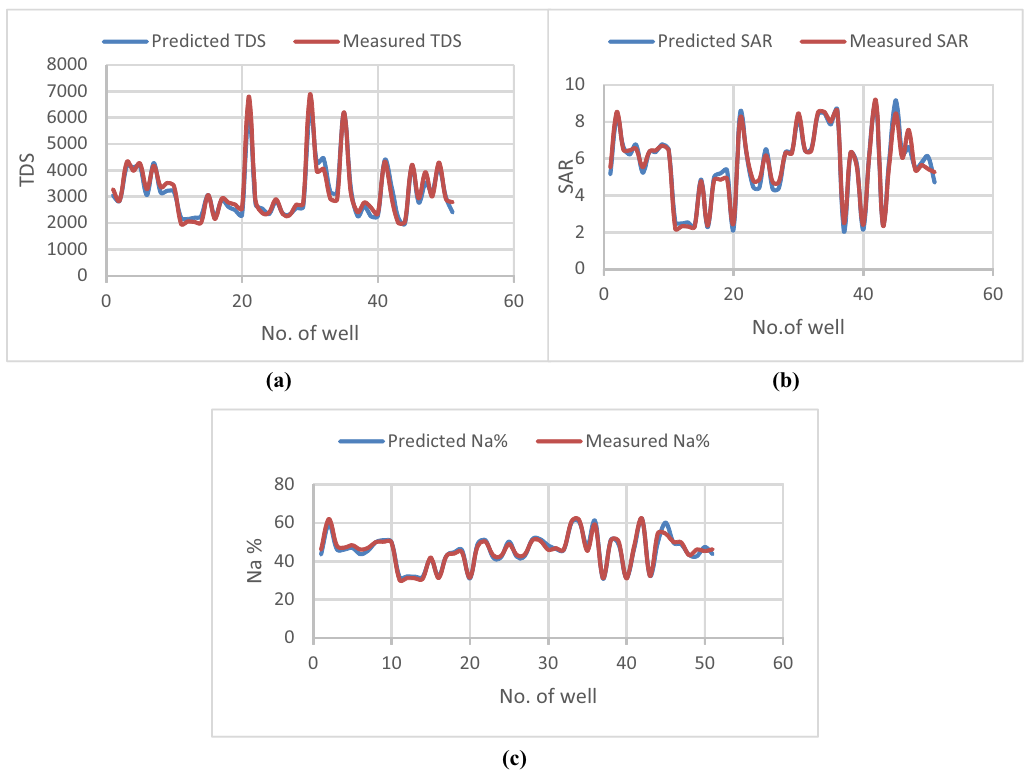
Figure 6: The variations of predicted and measured values. ( a ) The values of TDS between predicted and measured. ( b ) The values of SAR between predicted and measured. ( c ) The values of Na percent between predicted and measured.